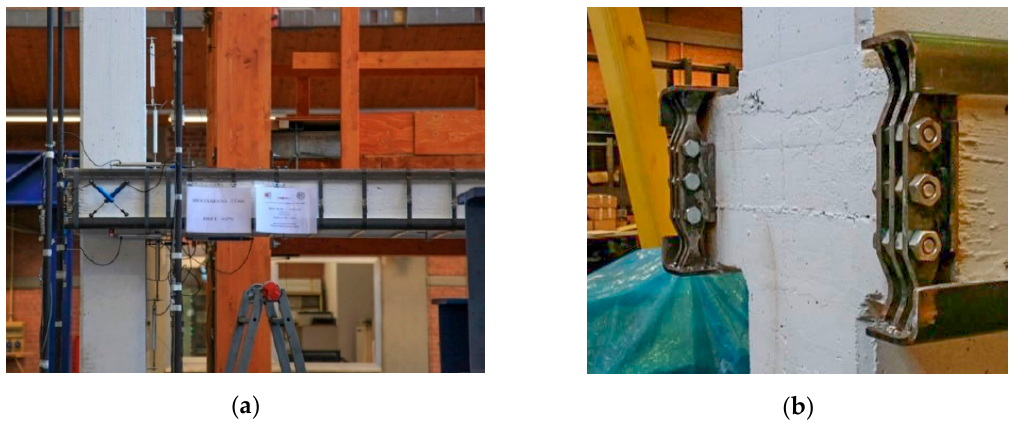
Figure 6. TS10 Specimen: ( a ) whole arrangement and ( b ) detail of the angles’ connection by X-shaped elements.